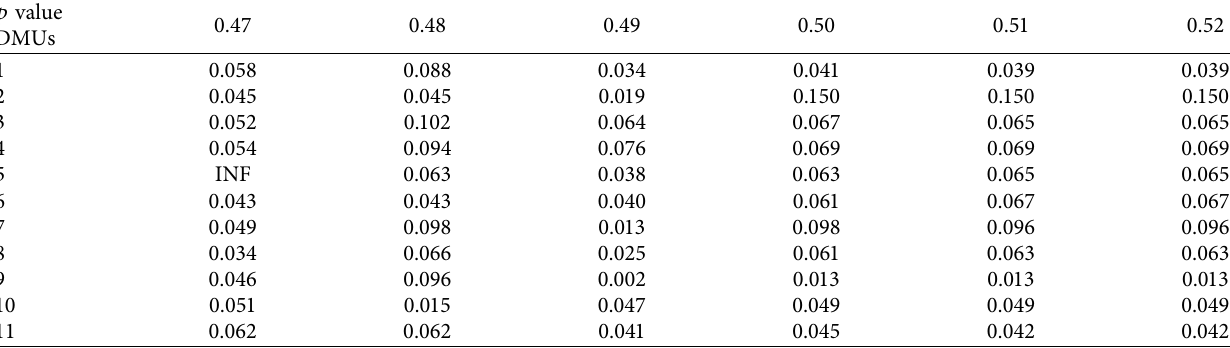
Table 6: The results of solving model (12).